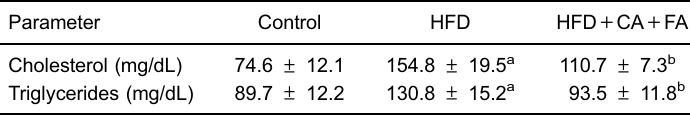
Figure 6. Effect of a high-fat diet (HFD) with combined treatment of caffeic acid (CA) and ferulic acid (FA) (0.9 and 50 mg (cid:3) kg – 1 (cid:3) day – 1 , respectively) on liver. Histology of liver stained with hematoxylin and eosin from A , control (CTRL) mice; B , HFD mice, arrows indicate the hepatic steatosis; C , HFD + CA + FA mice. All magni fi ca- tions are (cid:1) 200. Scale bar: 50 m m. D , Relative mRNA analysis of genes related to triglyceride metabolism: carbohydrate-responsive element- binding protein (ChREBP); sterol regulatory ele- ment-binding protein 1 (SREBP-1c); fatty acid synthase (FAS); diacylglycerol O-acyltransferase 2 (DGAT-2); microsomal triglyceride transfer pro- tein (MTTP); adipose triglyceride lipase (ATGL); peroxisome proliferator-activated receptor alpha (PPAR a ). E , Cholesterol metabolism: sterol reg- ulatory element-binding protein 2 (SREBP-2); liver X receptor alpha (LXR- a ); low-density lipoprotein receptor (LDL-R); acetyl-CoA acetyltransferase 1 (ACAT-1); 3-hydroxy-3-methyl-glutaryl-CoA reduc- tase (HMG-CoA). Data are reported as means ± SEM of fi ve animals per group. ANOVA followed by the Student Newman-Keuls test were used for statistical analyses.